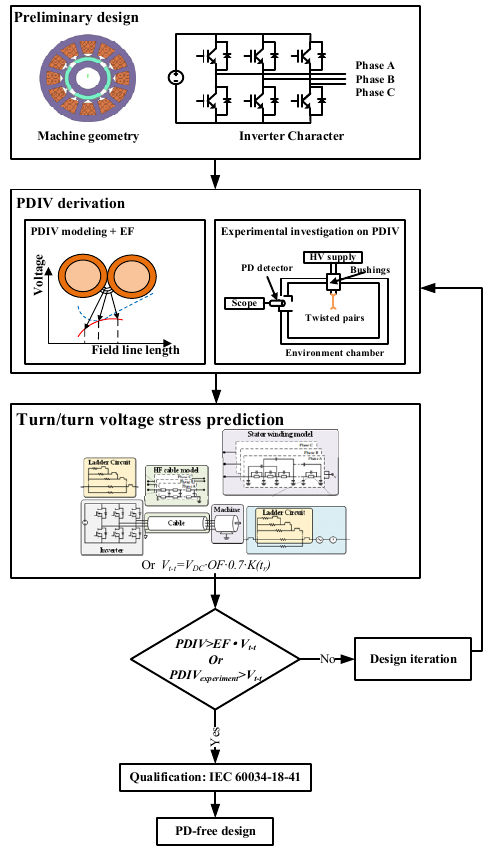
Figure 16. A summarization of PD-free design process.